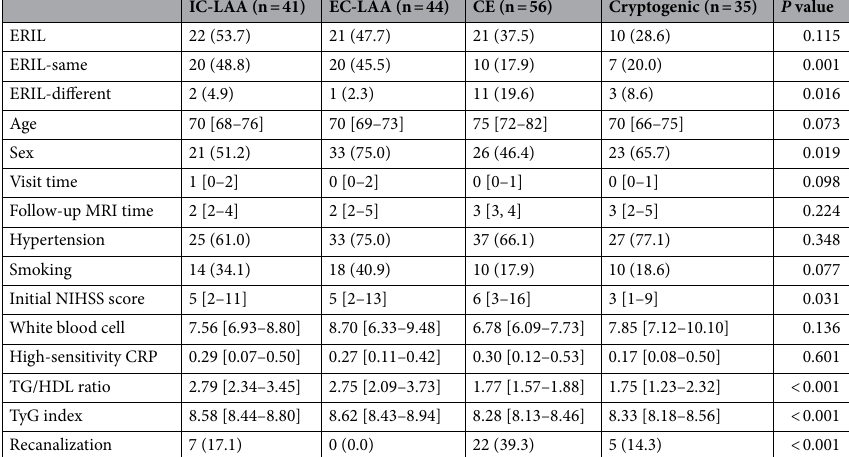
Table 3. Comparison of characteristics of patient groups according to stroke mechanism. IC-LAA intracranial large artery atherosclerosis, EC-LAA extracranial large artery atherosclerosis, CE cardioembolic, ERIL early recurrent ischemic lesion, ERIL-same ERIL within the same vascular territory, ERIL-different ERIL within different vascular territory, MRI magnetic resonance imaging, NIHSS National Institutes of Health Stroke Scale, CRP C-reactive protein, TG triglyceride, HDL high-density lipoprotein, TyG index = triglyceride-glucose